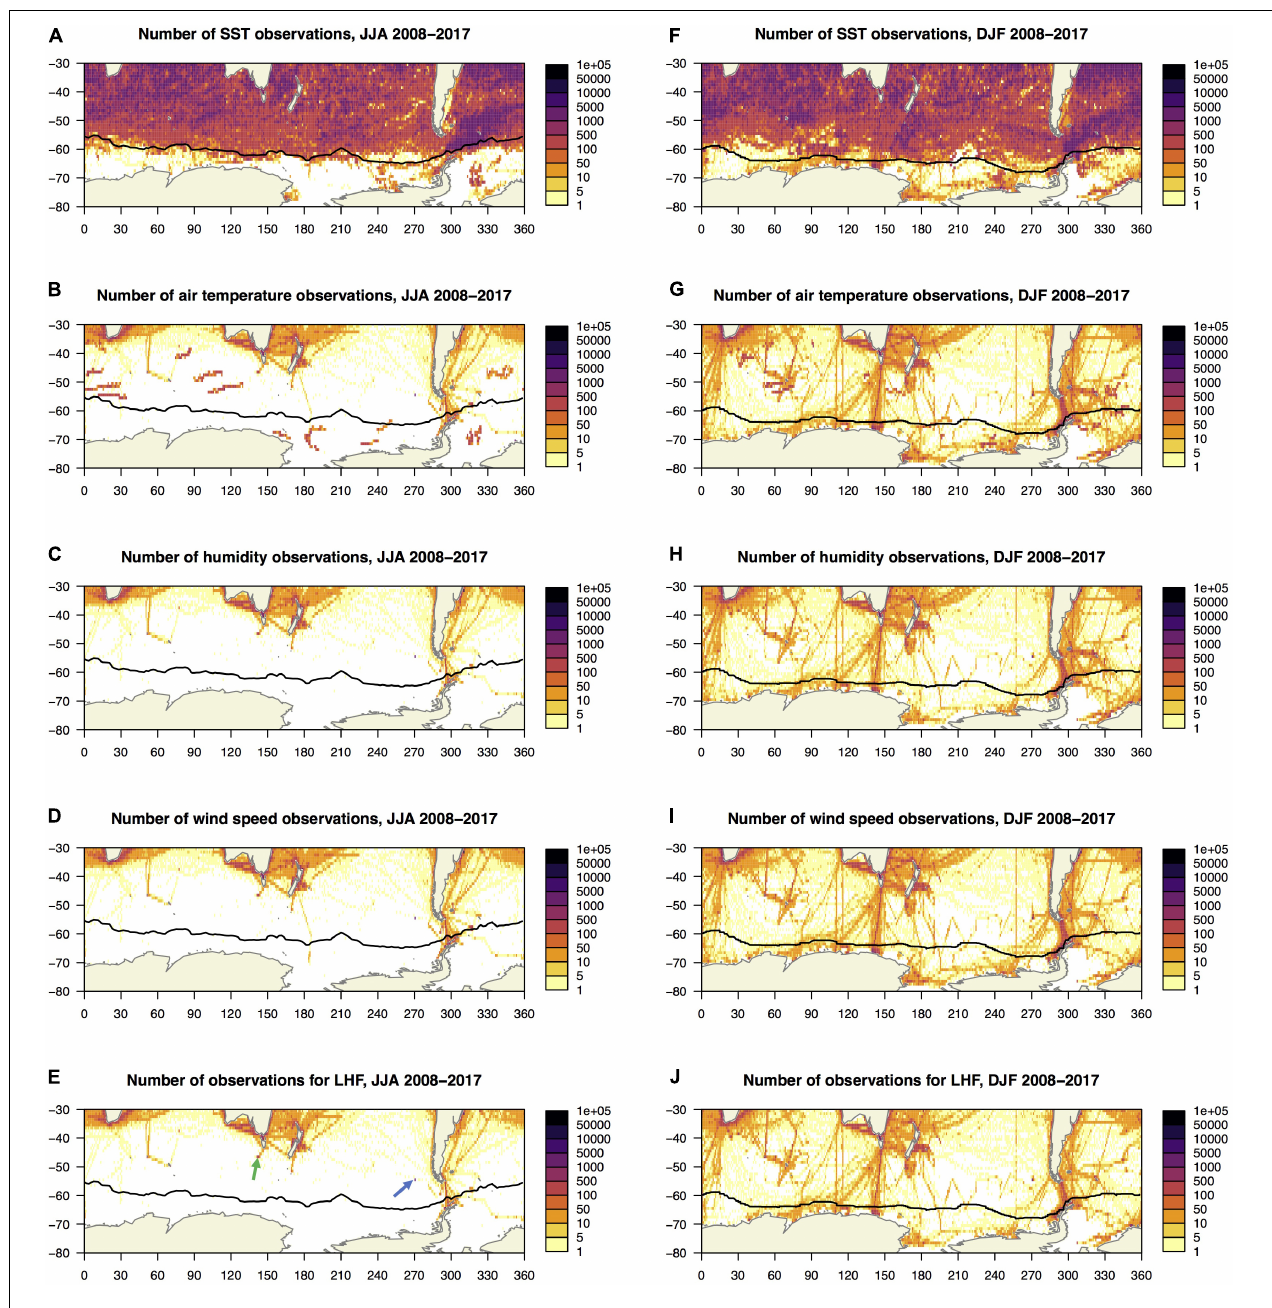
FIGURE 1 | Observation count for critical air-sea flux ocean and atmospheric parameters for austral winter (June–August) on the left versus summer (December–February) on the right, for 10 years (2008–2017): (A,F) SST, (B,G) air temperature, (C,H) humidity, (D,I) wind speed, and (E,J) latent heat flux (LHF). Humidity observations include dew point temperature and relative humidity. LHF observations include co-located measurements of SST, air temperature, humidity and wind speed. Data from International Comprehensive Ocean-Atmosphere Data Set (ICOADS), as described by Freeman et al. (2017). The two existing surface mooring sites, OOI and SOFS, are indicated in panel (E) using a blue and green arrow, respectively. Black contour denotes the 10-year mean of the 15% sea ice concentration from NCEP/DOE AMIP-II Reanalysis, representing the sea-ice edge in winter (left panels) and summer (right